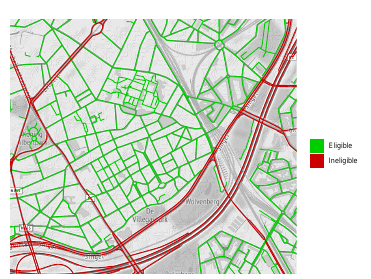
Figure 7. Additional to a data table, the Antwerp dashboard also includes a map with pointers for proposed garden streets and overlay polygons for the estimated benefits per hydrological catchment. traffic functionality of streets in order to make a classification of streets that are eligible and streets that are not eligible to be- 8).